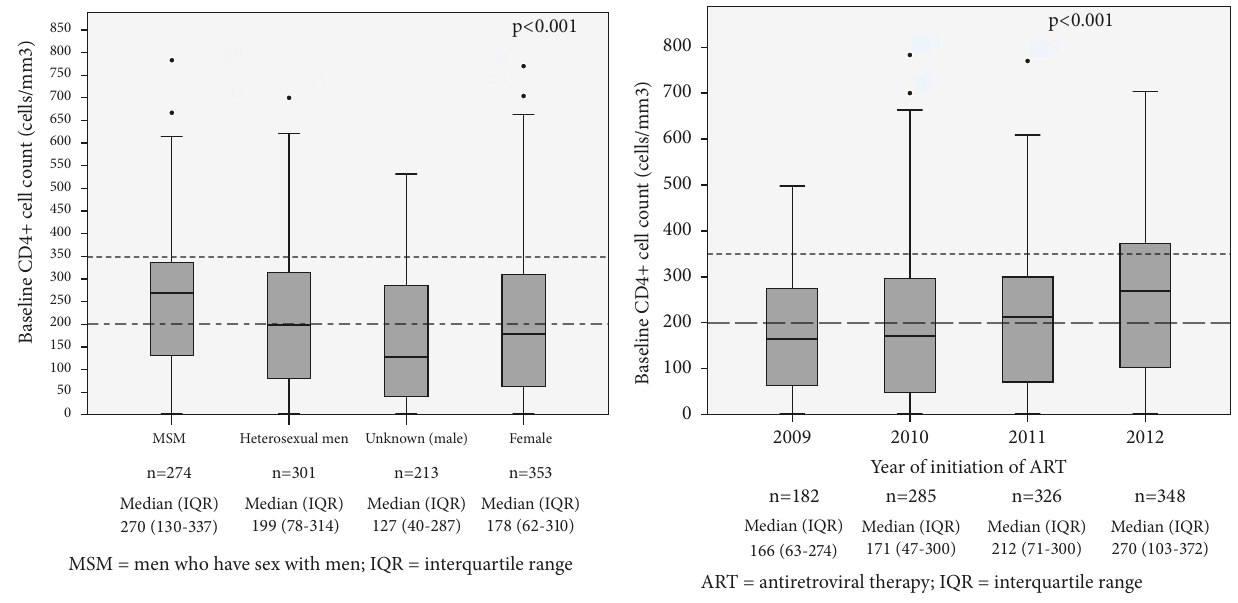
Figure 1: Distribution of absolute values of CD4+ cell count at initiation of ART among people living with HIV or AIDS, according to sex and sexual orientation (a) and year of treatment initiation (b). Metropolitan area of Goiˆania, Midwestern Brazil,